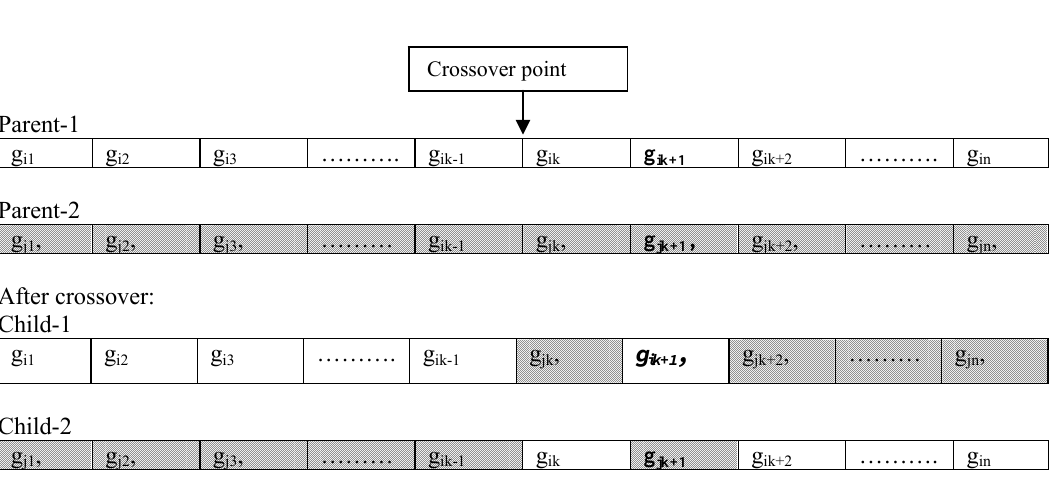
Figure 1- Effects of gene silencing after crossover